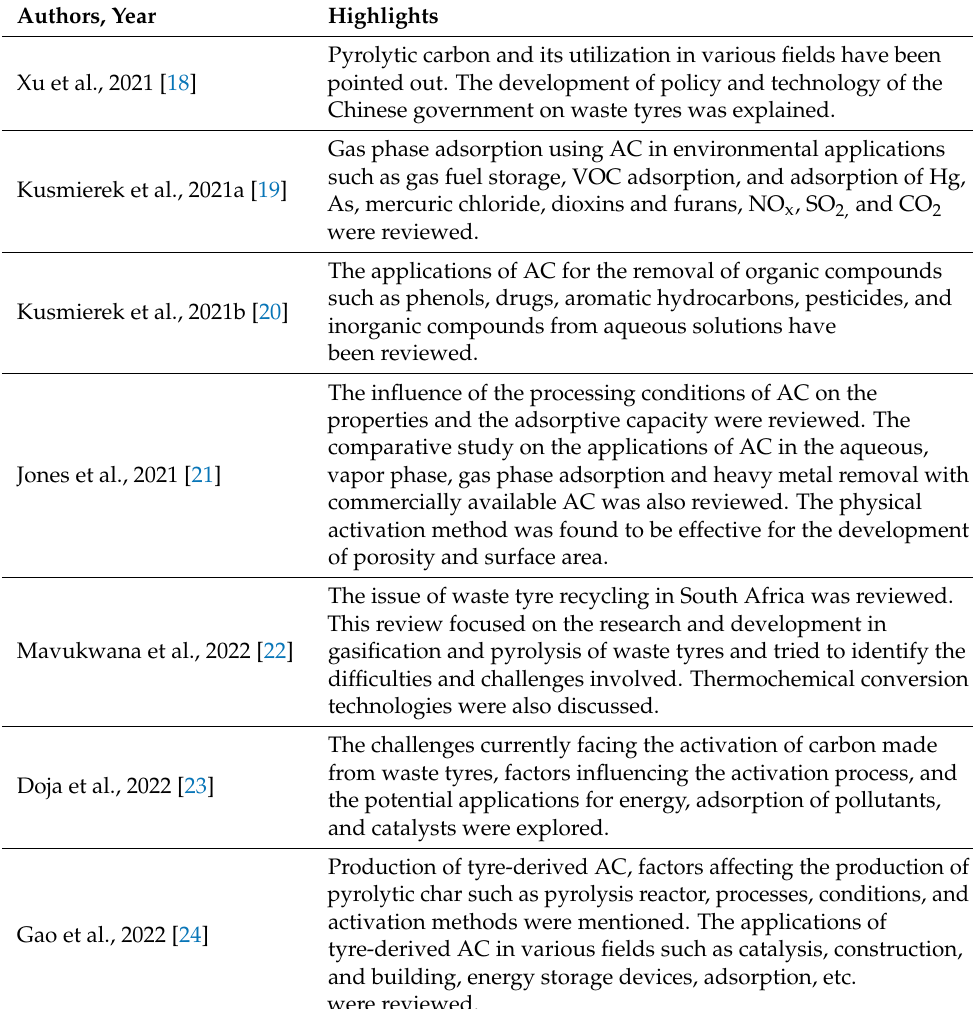
Table 1. Summary of recent reviews on activated carbon derived from waste